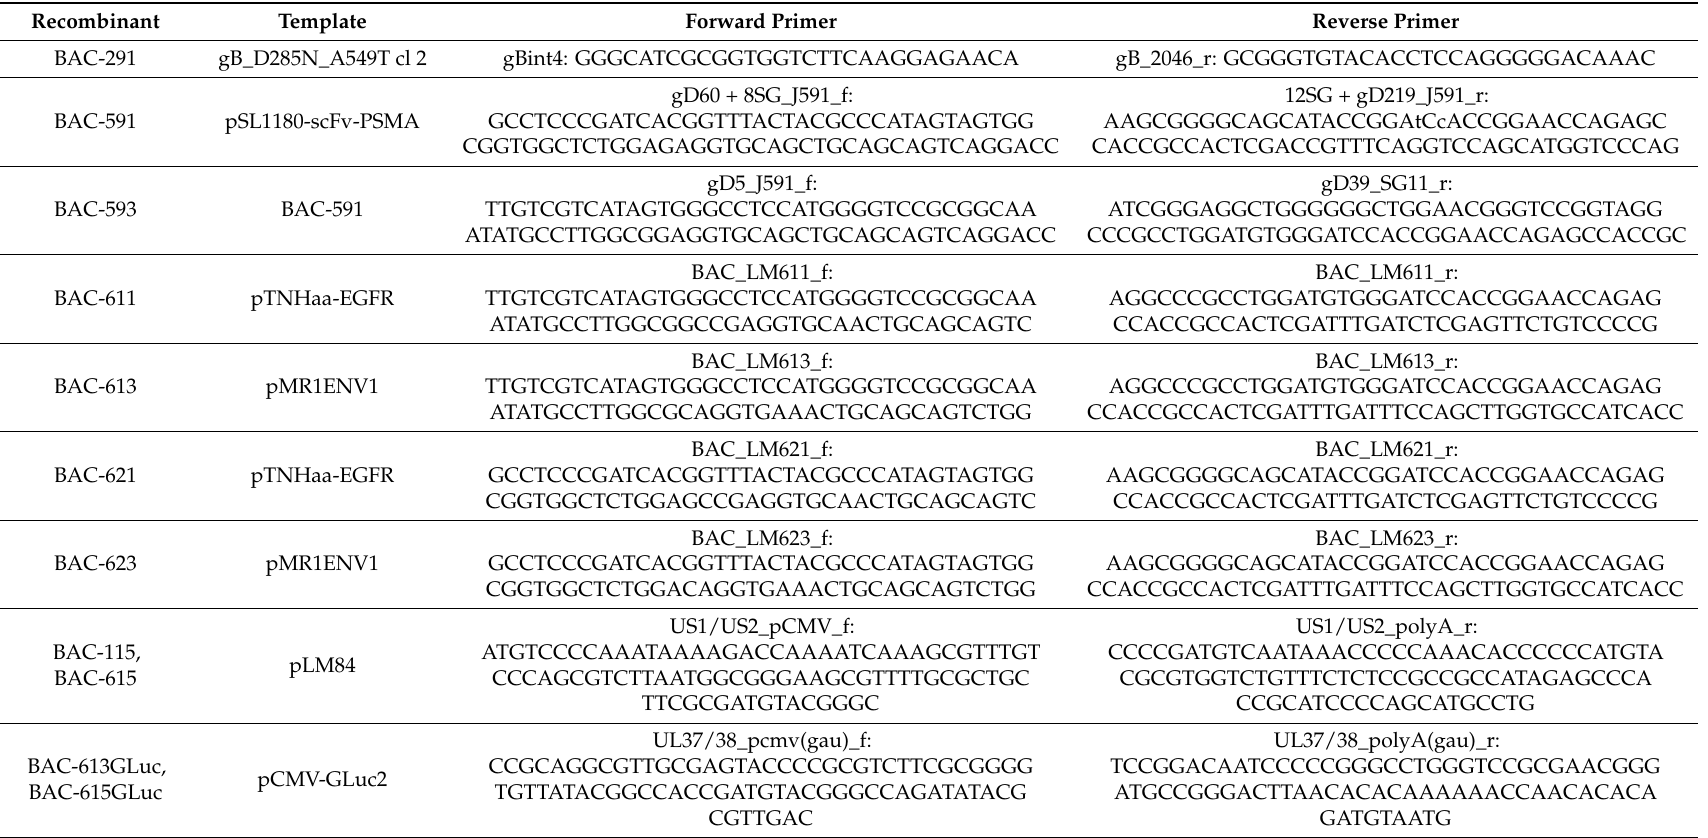
Table 4. Templates and primers for the second step of galK